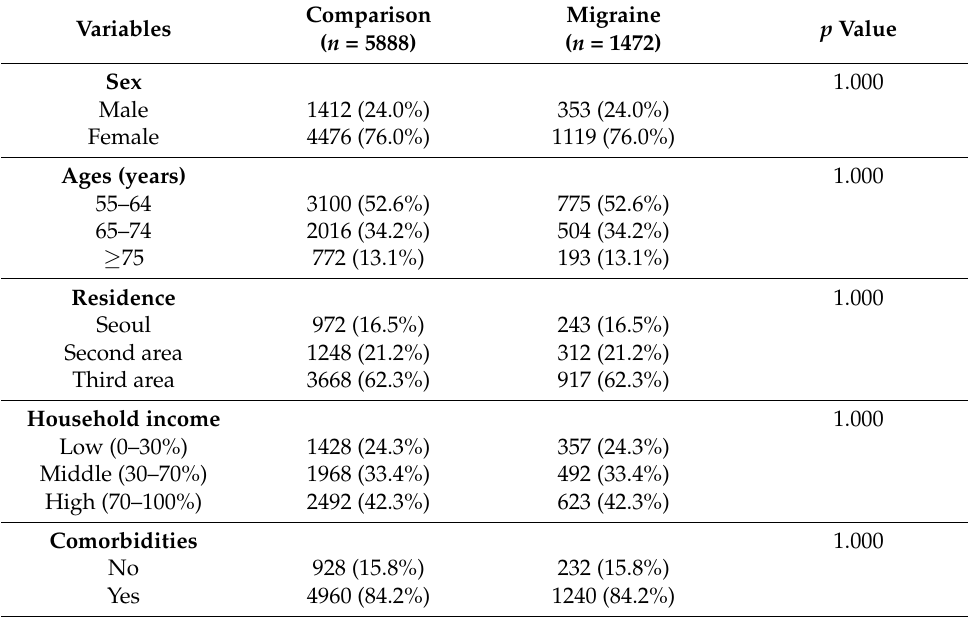
Table 1. Characteristics of the study